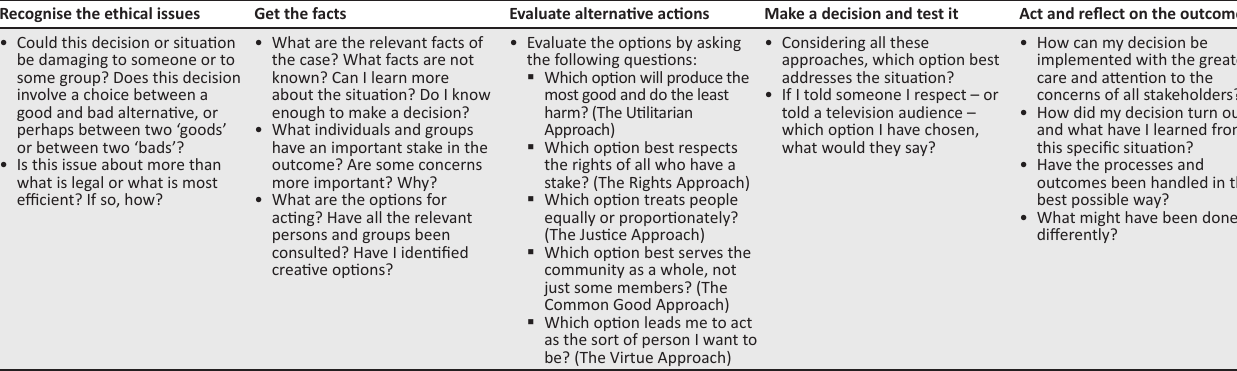
TABLE 2: Stages of the ethical